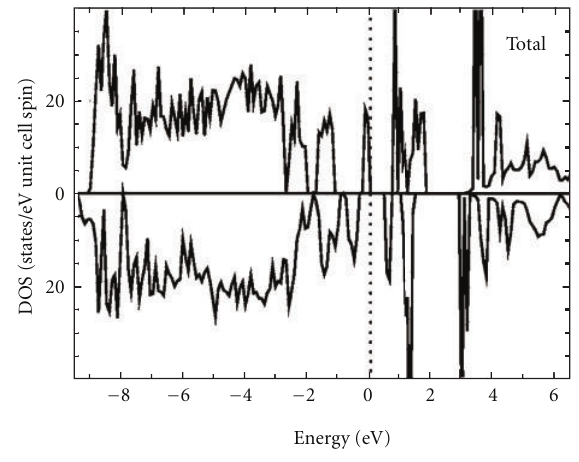
Figure 15: The total DOS obtained from LSDA+ U calculations with U = 5 . 5 eV and J = 1 eV for the low-temperature P 2 1 /c phase of Fe 2 OBO 3 [211]. The top of the valence band is shown by dotted lines.